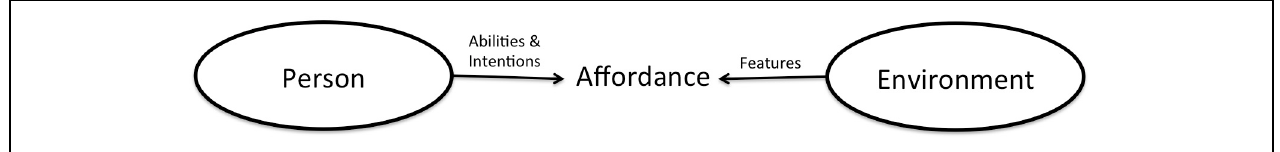
FIGURE 2 | Affordance according to Gibson (1977), is a transactional relationship between animal (e.g., person) and environment.